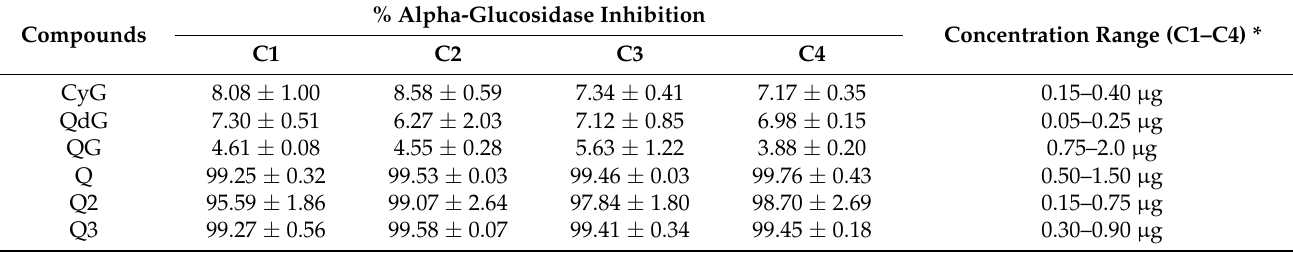
Table 4. α -glucosidase inhibitory activity of major compounds of “Ramata di Montoro” and “Rossa di Tropea” onion skin extracts.